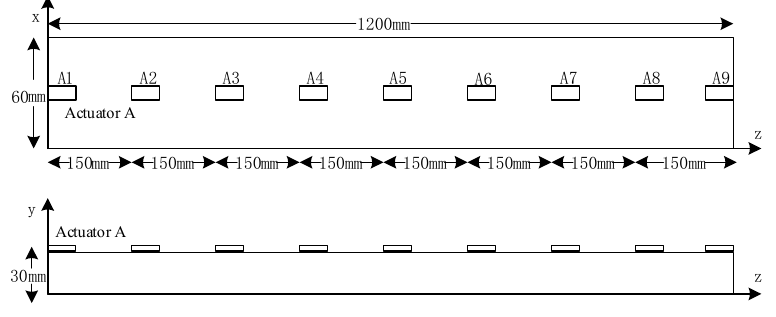
Figure 5. Map of sensor network configuration.